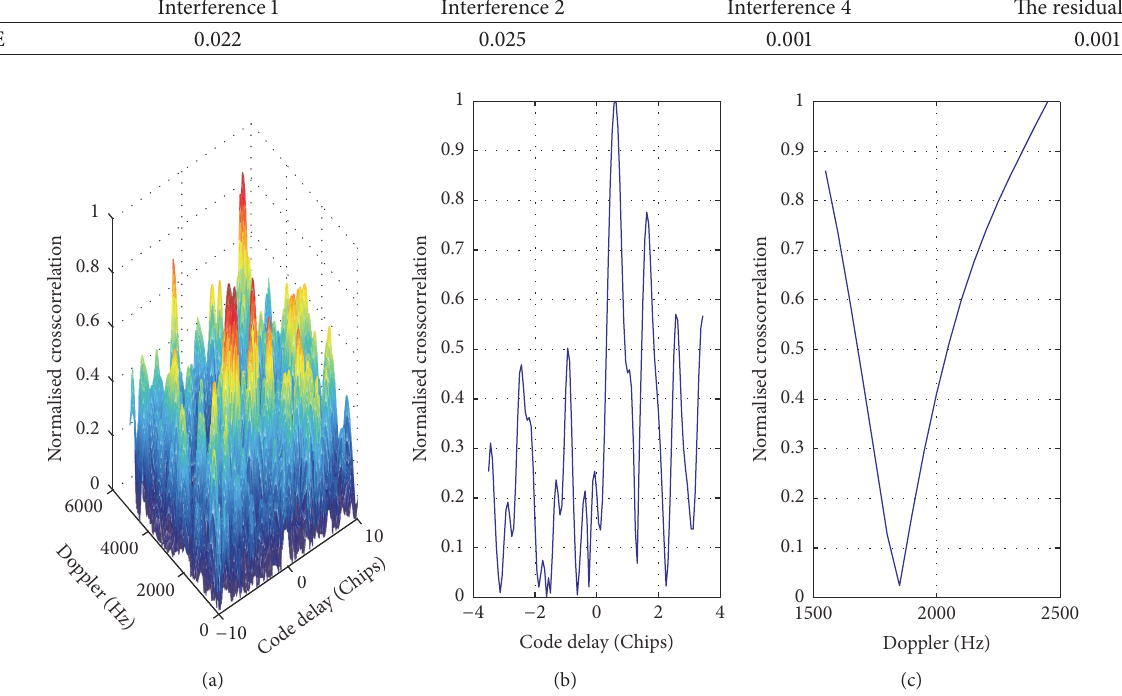
Figure 18: Correlation peaks after interference suppression by ST-MPDR beamformer for scenario